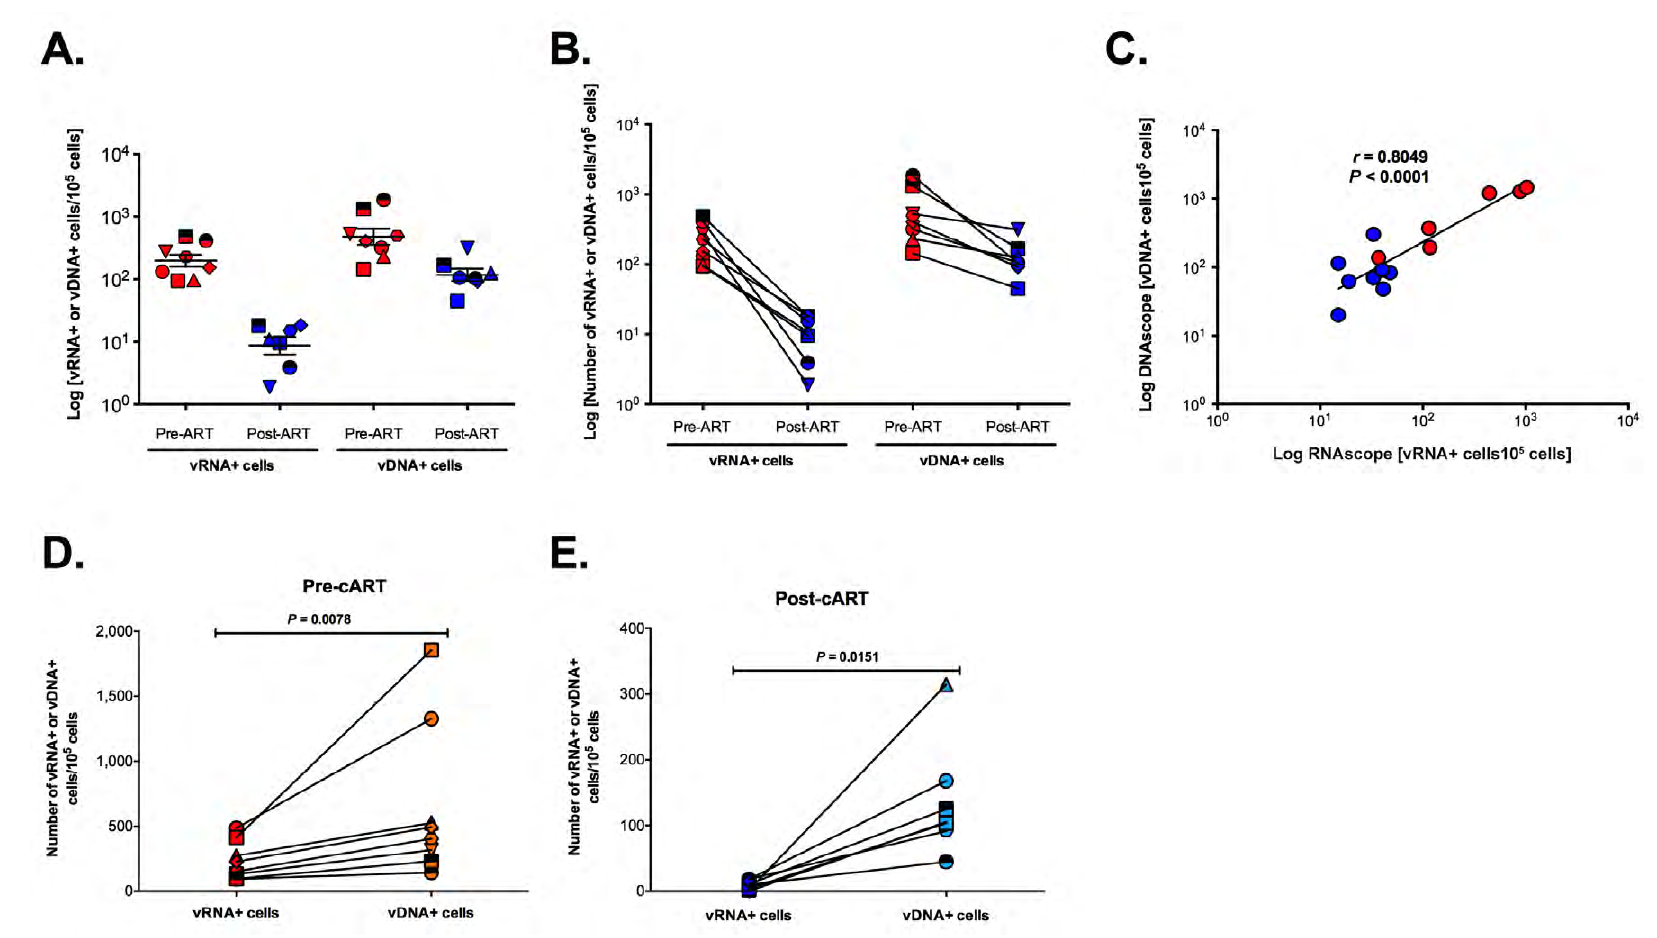
Supplemental Figure 7. Effect of cART on the number of vRNA+ and vDNA+ cells in secondary lymphoid tissues in vivo . (A) The mean change in vRNA+ and vDNA+ cells before and during 26 weeks of combination antiretroviral therapy (cART). (B) The individual animal change in vRNA+ and vDNA+ cells before and during 26 weeks of cART. (C) The relationship between vDNA and vRNA before and during cART. (D) The compari- son in the number of vRNA+ and (E) vDNA+ cells before and during 26 weeks of